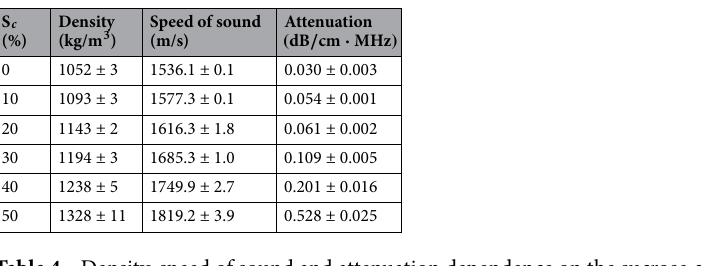
Table 4. Density, speed of sound and attenuation dependence on the sucrose concentration for the fabricated phantoms (through-transmission